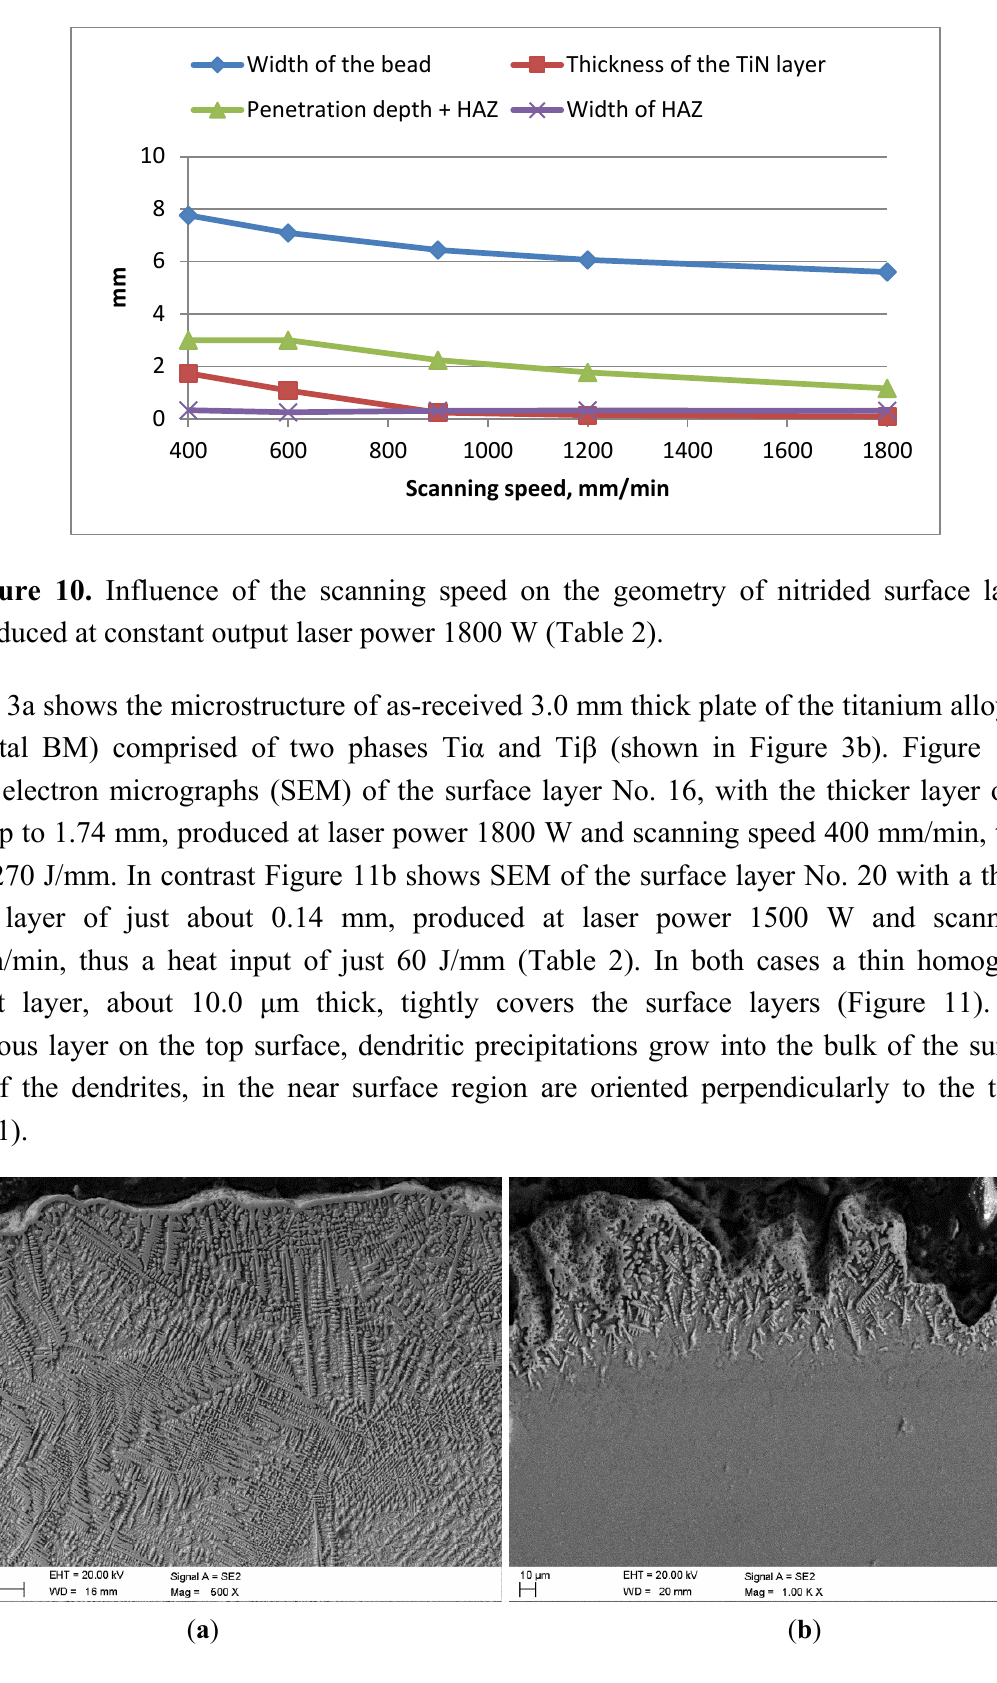
Figure 11. ( a ) Scanning electron micrograph of the nitrided surface layer of sample No. P16 (Table 2) and ( b ) sample No.